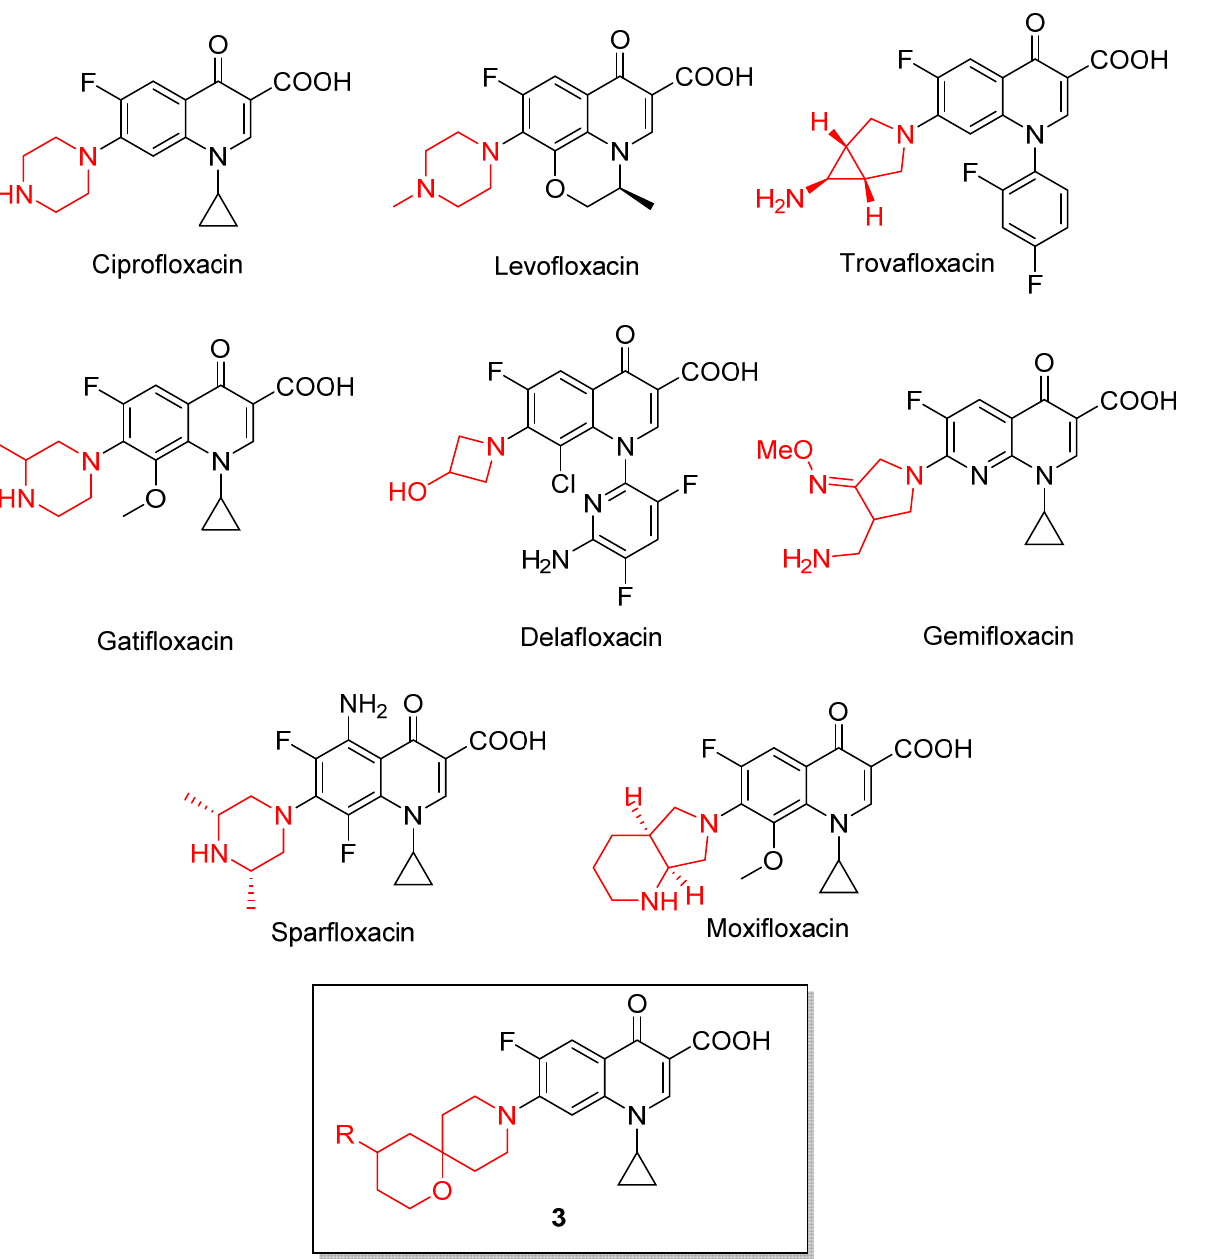
Figure 1. Structures of exemplary approved fluoroquinolone antibacterials as well as fluoroquinolone chemotype 3 explored in this work.